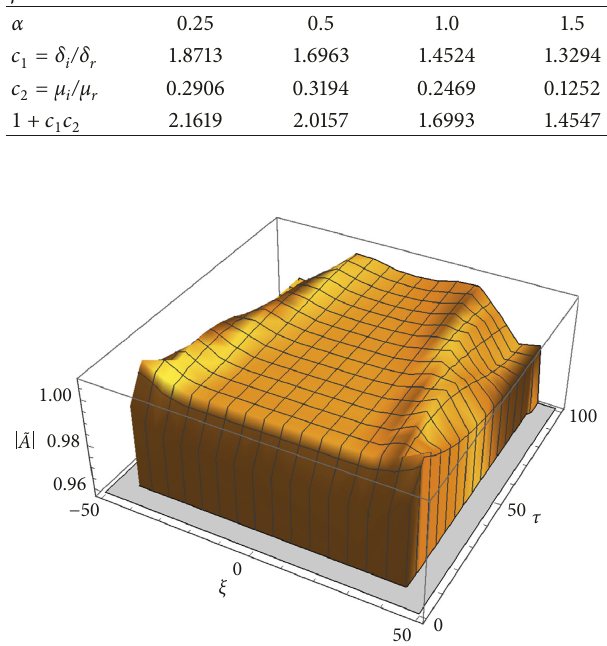
Figure 5: Plot of the | 􏽥 A | for the case c initial condition corresponds to small random noise).